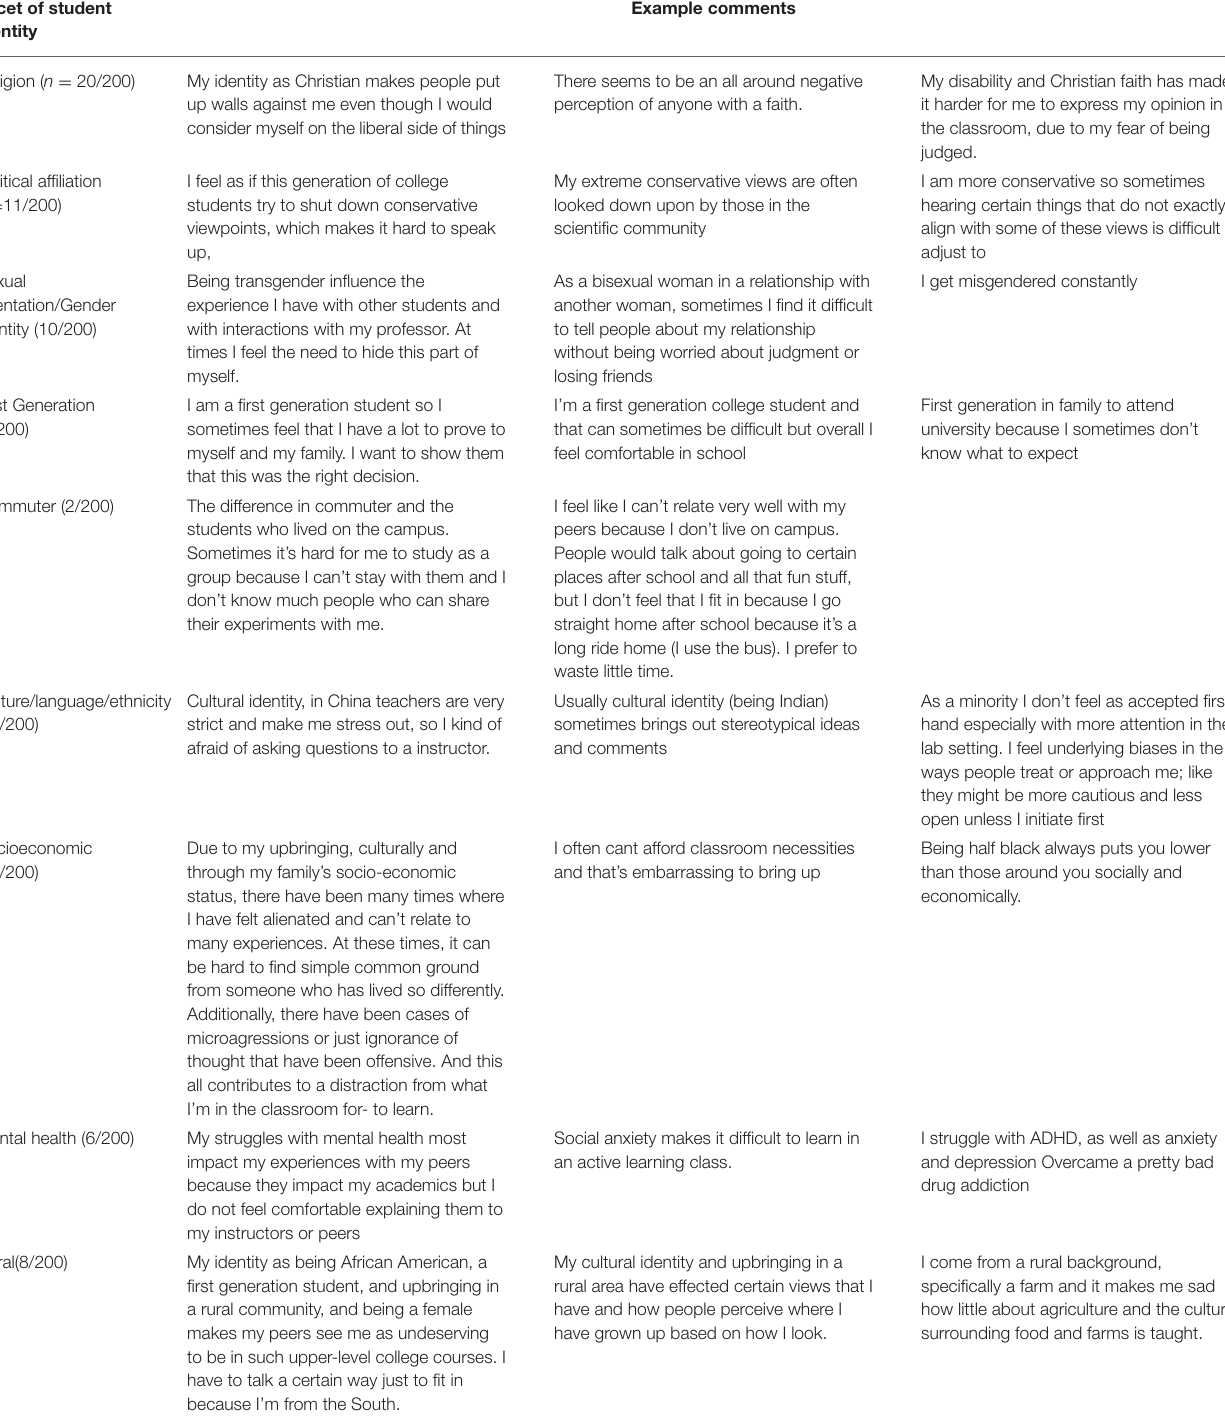
TABLE 5 | We asked students which of their “ hidden identities ” influence social learning environments, and to describe in detail how those identities impacted experiences with peers or the instructor(s) in the classroom. Facet of student